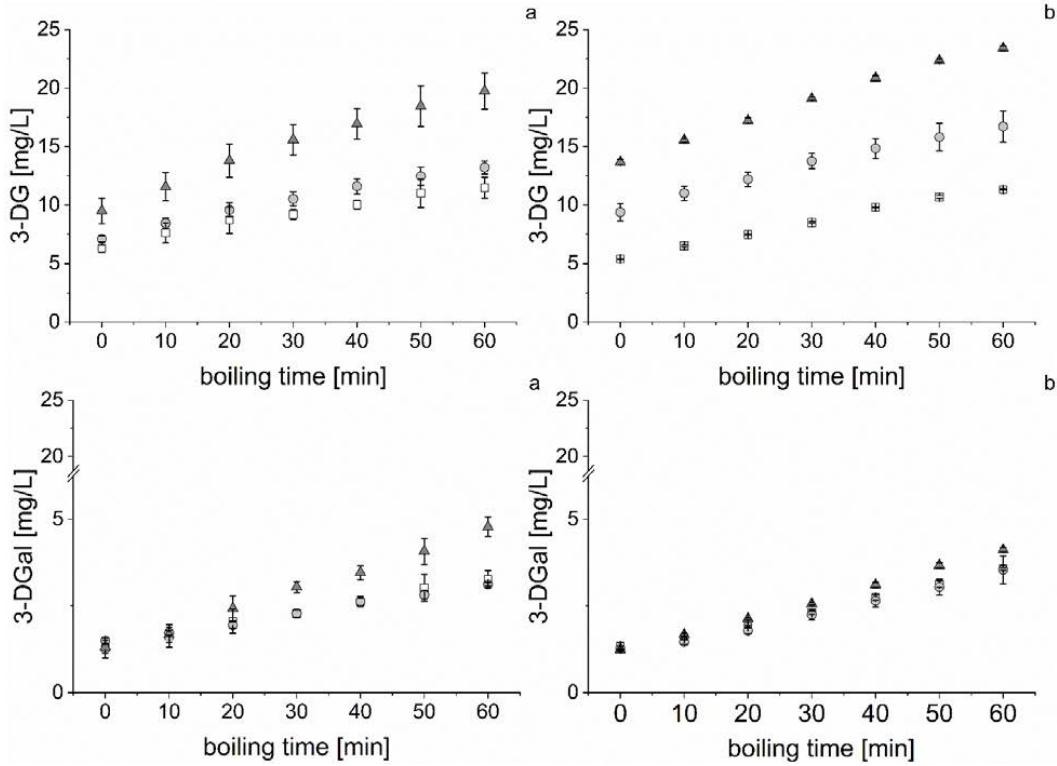
Figure 3. Formation of 3-DG and 3-DGal (( a ) = B1, ( b ) = B2)) during wort boiling; squares: P1, points: P2, triangles: P3 ( n = 3).